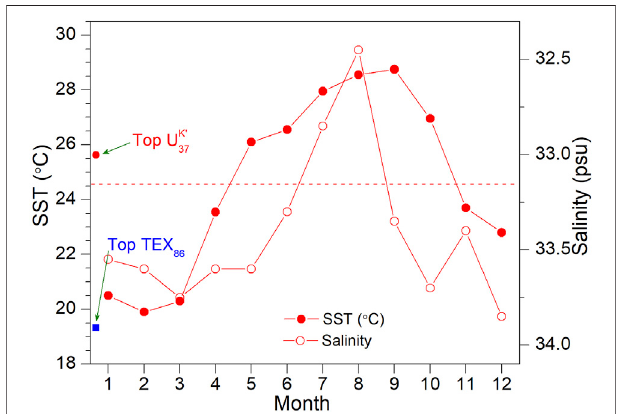
FIGURE2| Comparisonbetweentemperatureestimatesatthetopmost sample based on U K ′ 37 and TEX 86 proxies, respectively. Observational SSTs and salinity near the core site (112.125 ° N, 21.625 ° E, Casey, 2013; Zweng etal.,2013)arealsoshown.Thedashedlinerepresentstheannualmean SST